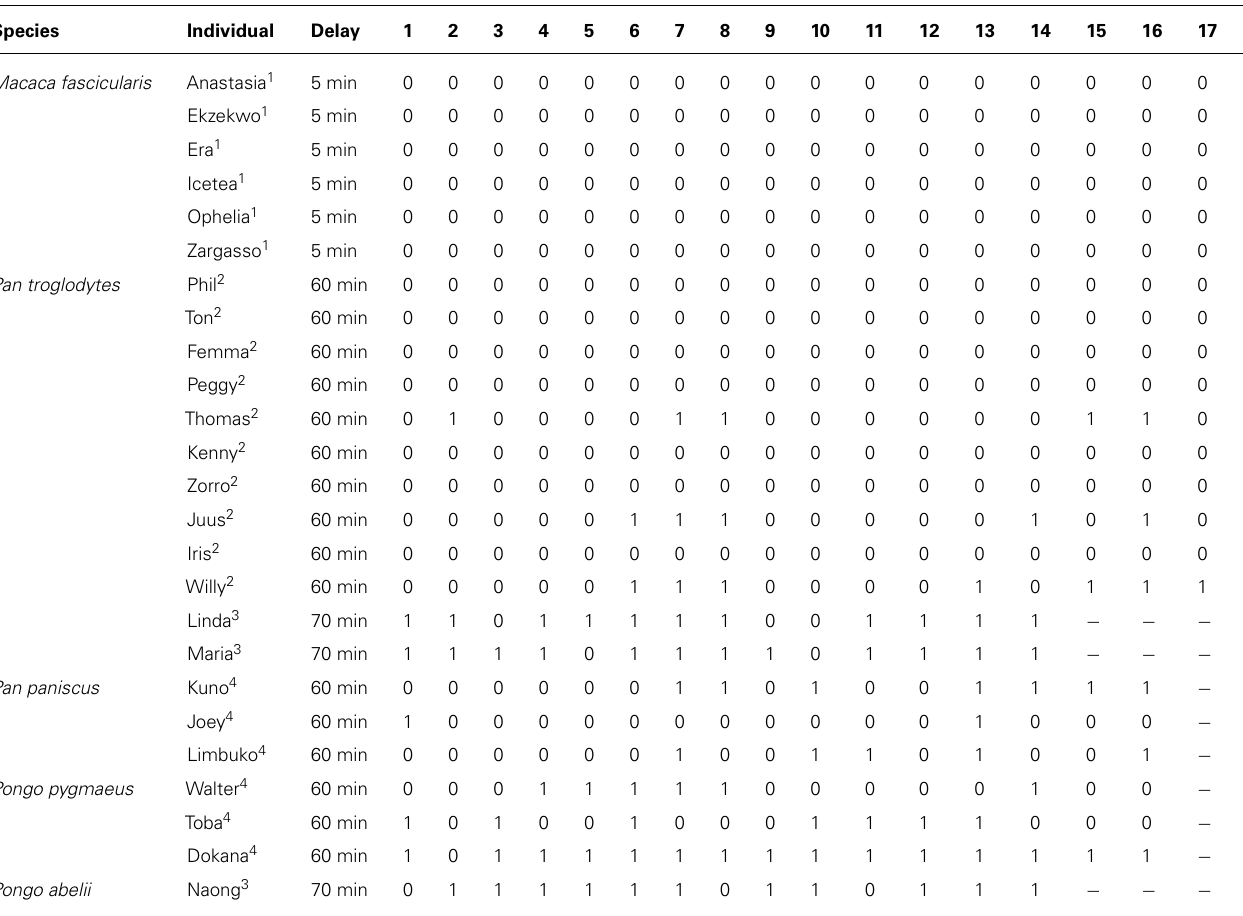
Table 1 |The trial-by-trial performance of several primate species.